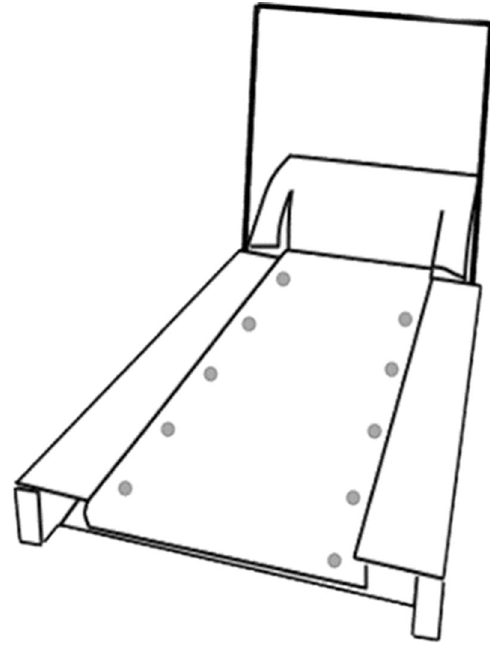
Figure 1. Schematic drawing of marker placement on the